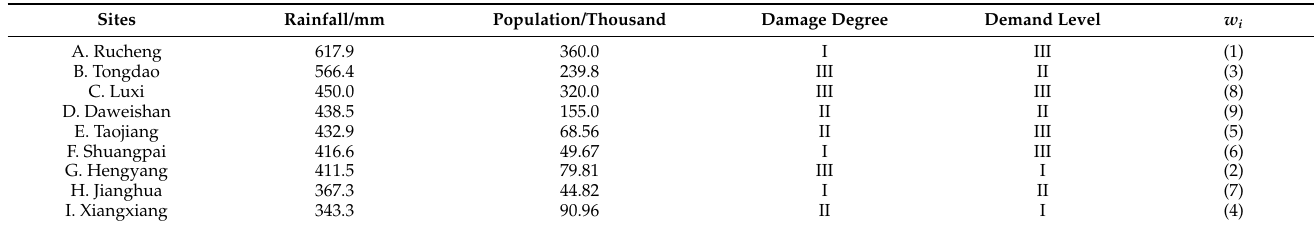
Table 1. Related data of disaster areas.